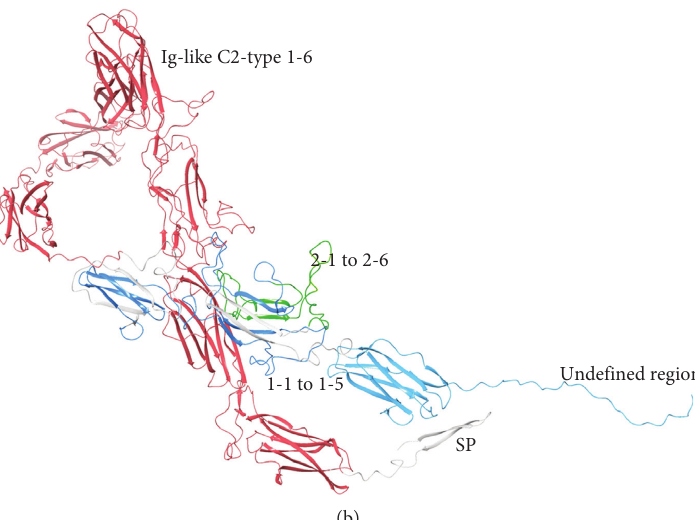
Figure 2: MYLK molecular model for the full-length human sequence consisting of 1914 amino acids and the variant p.S1218del. All protein residues shown are rendered in ribbons and colored by the domain map at the top. (a) Full-length model for the entire MYLK structure in ribbon is given and labeled by the domains in the key. (b) The p.S1218del structure for MYLK is shown and rendered similarly to that in panel (a). Colors in the domain legend key (top) match ribbon colors for both models